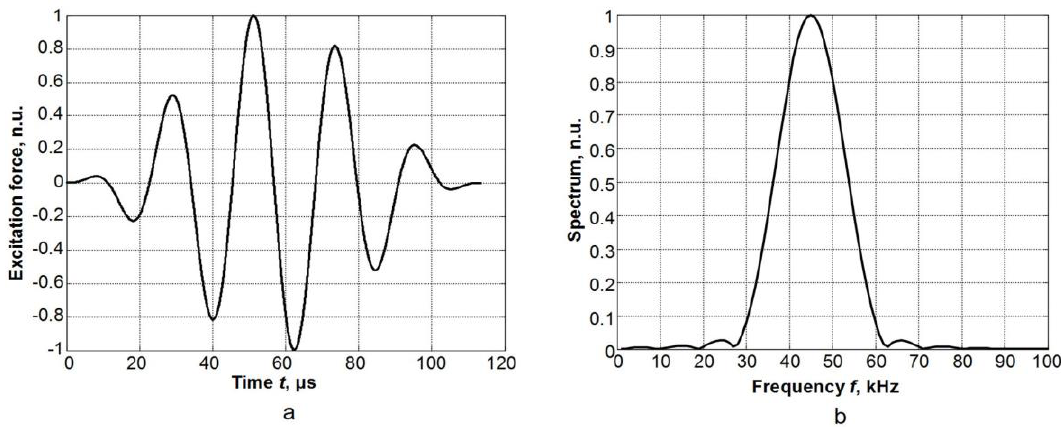
Figure 3. Time diagram ( a ) and spectrum ( b ) of the excitation force; n.u. — normalised unit.